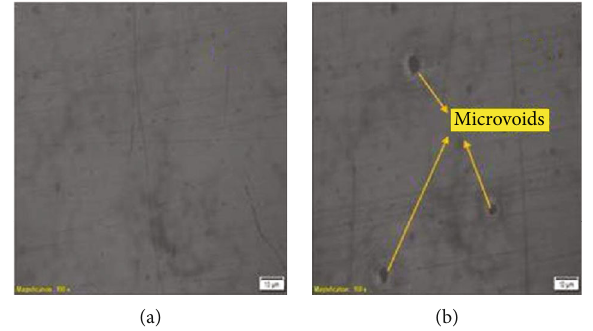
Figure 8: (a) Optical microscope image of 0.6 wt% PE/MWCNT. (b) Optical microscope image of 1wt%